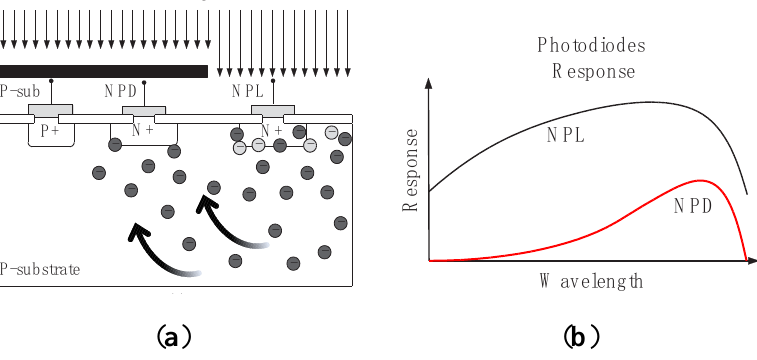
Figure 2. ( a ) Illustration of carrier generation and lateral carrier diffusion for short (light grey carriers) and long light wavelengths (dark grey carriers); ( b ) Effect of lateral carrier diffusion on photodiodes responsivities.